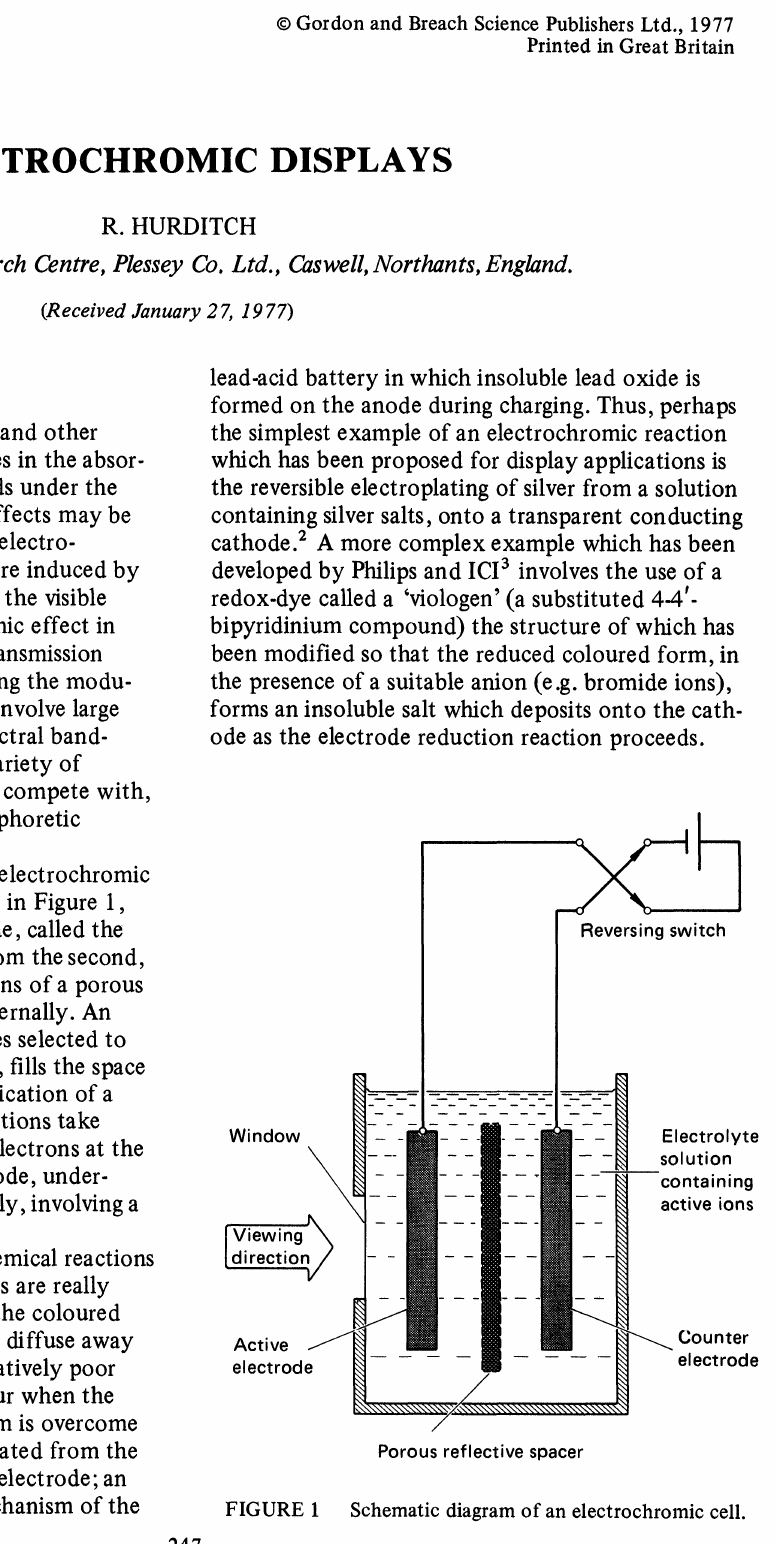
Porous reflective spacer FIGURE Schematic diagram of an electrochromic